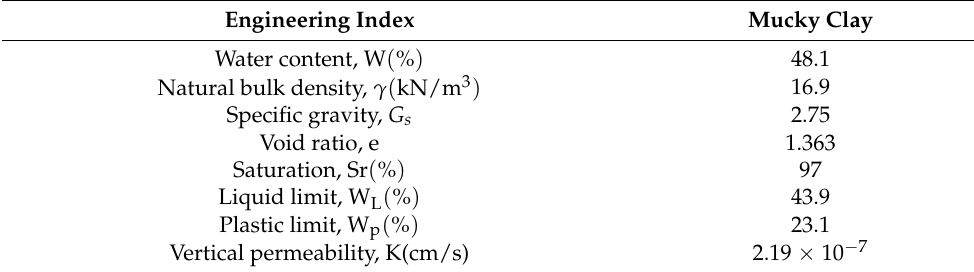
Table 2. The basic physical and mechanical properties of mucky clay.